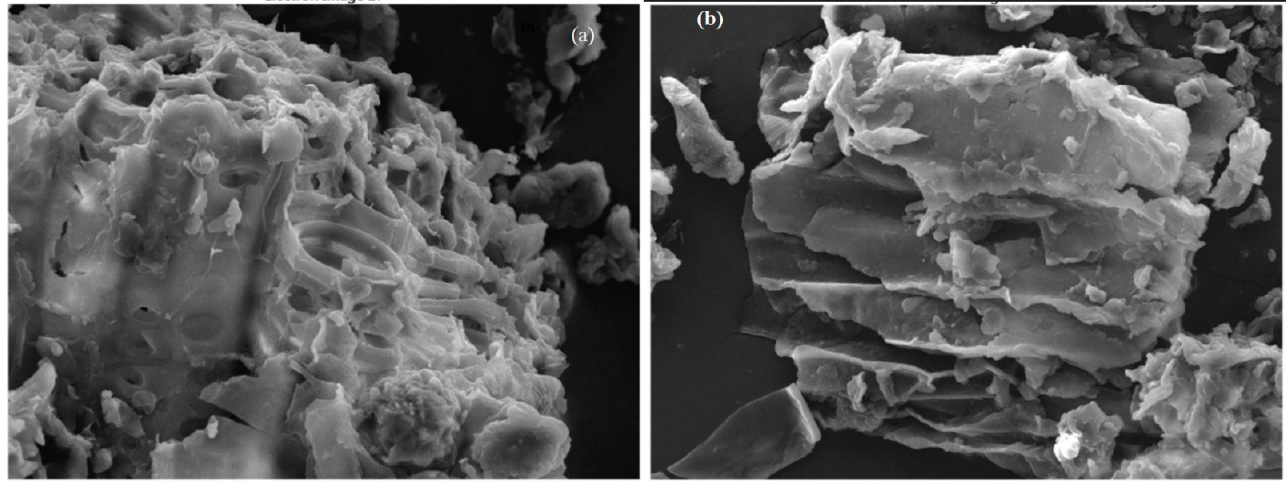
Figure 3 . SEM images of ( a ) Moringa peregrina biomass and ( b ) Moringa peregrina biomass treated with citric acid.